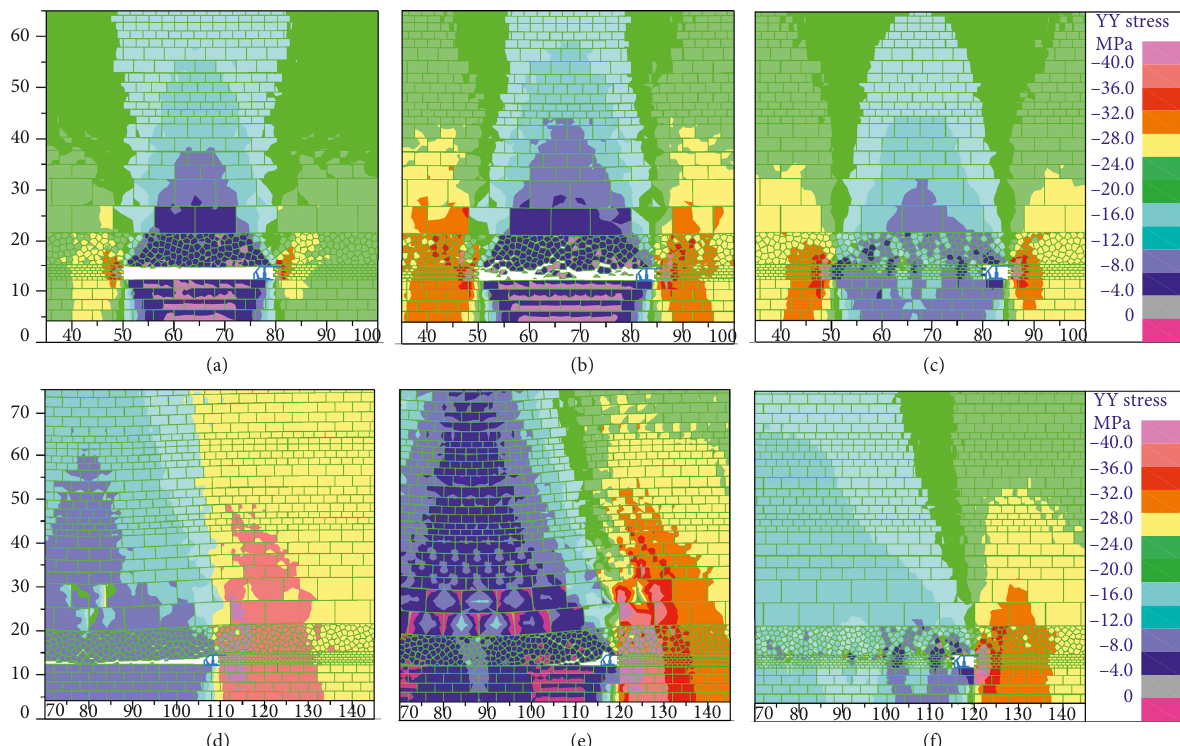
Figure 7: Vertical stress distribution characteristics of process stope under different roof management methods. (a) Nonbackfilling excavation 30m. (b) Nonbackfilling excavation 35m. (c) Backfilling excavation 35 m. (d) Nonbackfilling excavation 60 m. (e) Nonbackfilling excavation 70m. (f) Backfilling excavation